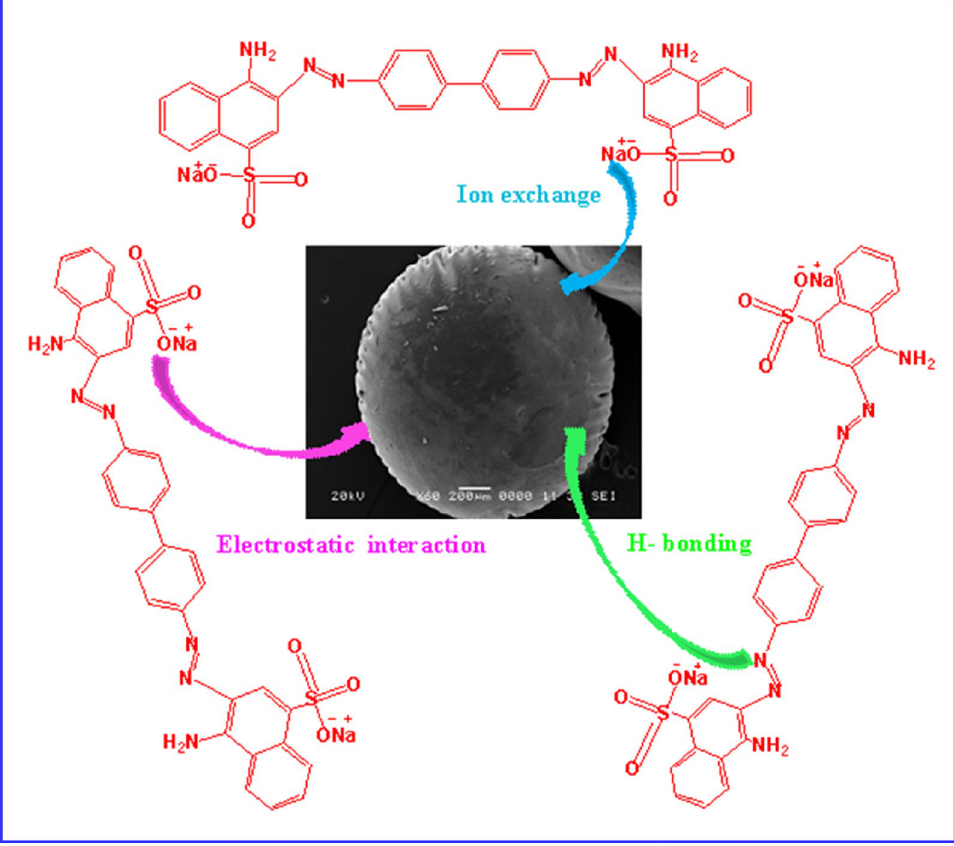
Figure 11. Proposed mechanism for the adsorption of CR dye onto K@AM-CTS composite